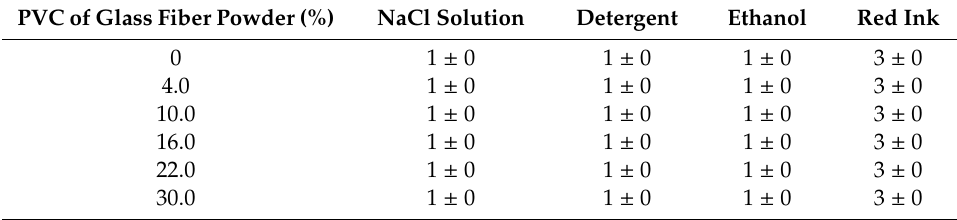
Table 9. Influence of the PVC of glass fiber powder on liquid resistance level of thermochromic waterborne